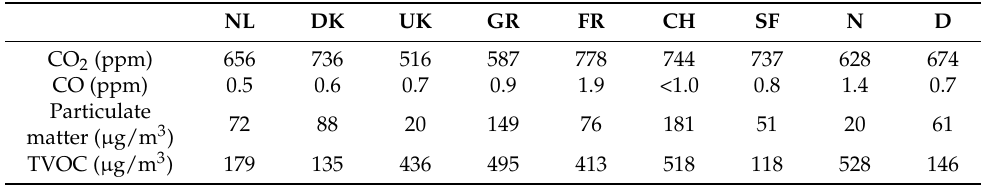
Table 3. Average CO 2 , CO, particulate matter, and TVOC concentrations measured in buildings in each country [18].